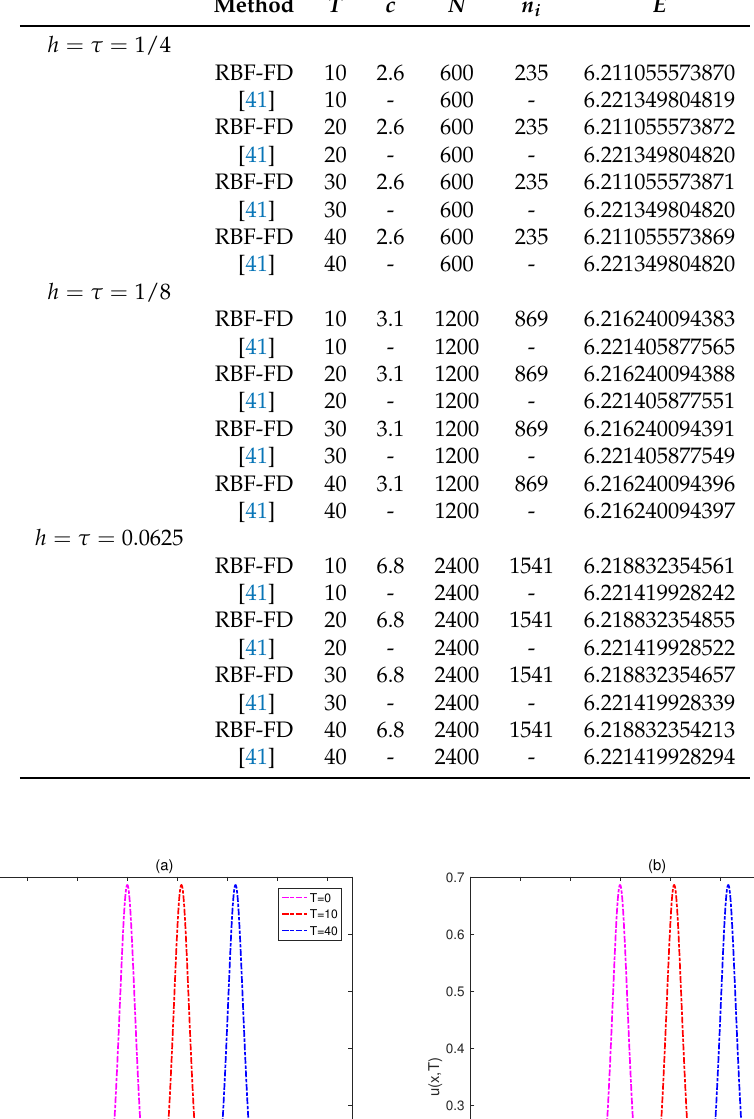
Table 5. The energy E under different mesh steps τ = h for Example 2.